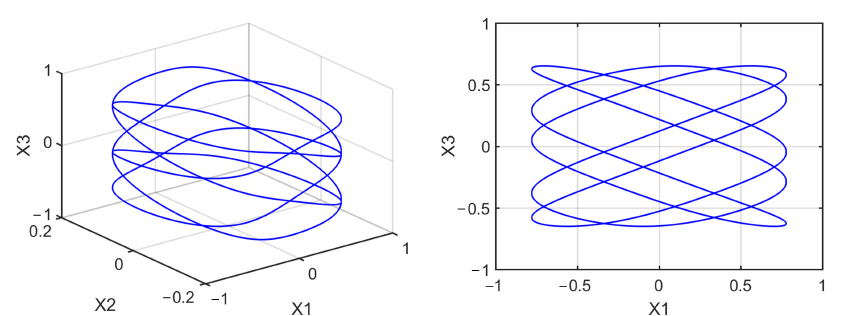
Figure A13. Periodic-4 motion of σ 1 = 0.3811.